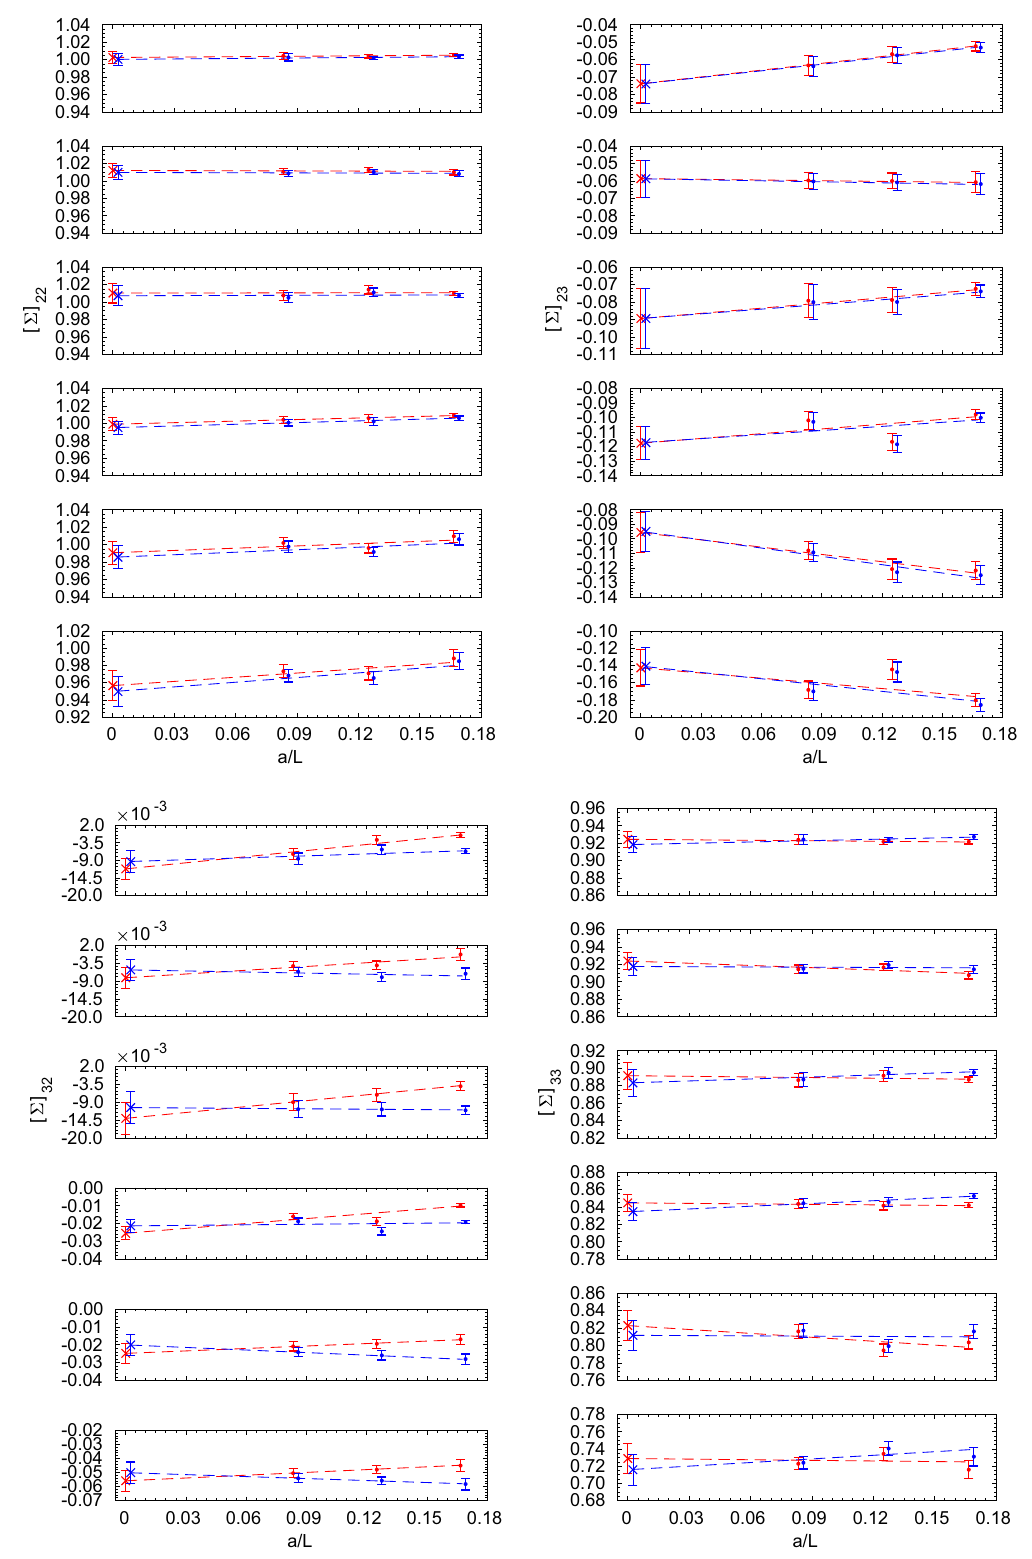
− ( u , a / L ) inblue,oftheoperatorbasis { Q −